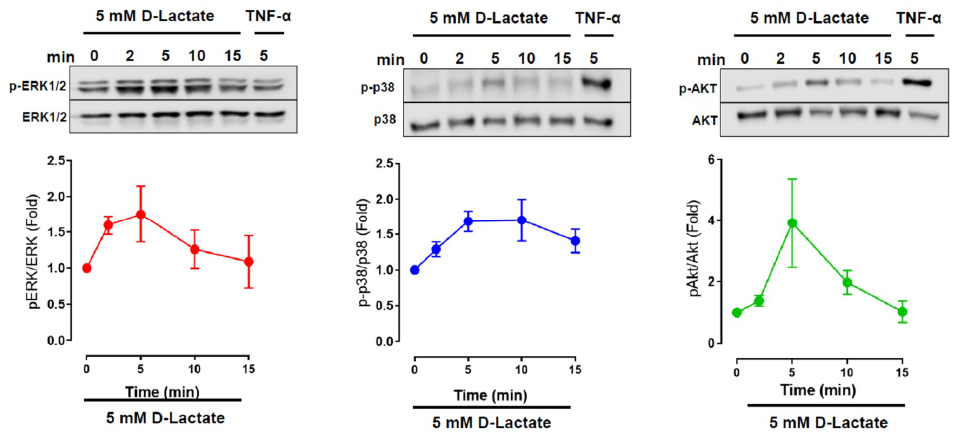
Figure 4. D-lactate increases the phosphorylation of ERK1 / 2, p38 and Akt in bFLSs. bFLSs were treated with 5 mM D-lactate at a range of time points (0, 2, 5, 10 and 15 min). Total protein was analyzed by sodium dodecyl sulfate polyacrylamide gel electrophoresis (SDS / PAGE) and immunoblotting using specific antibodies against the phosphorylated forms of ERK1 / 2, p38 and Akt. Total ERK1 / 2, p38 and Akt were also evaluated by western blot for comparison. The images of one representative experiment are shown. The densitometry ratios of phospho extracellular signal-regulated kinase / extracellular-regulated kinase (pERK / ERK), p-p38 / p38 and p-Akt / Akt are shown in the graphs ( n = 3).